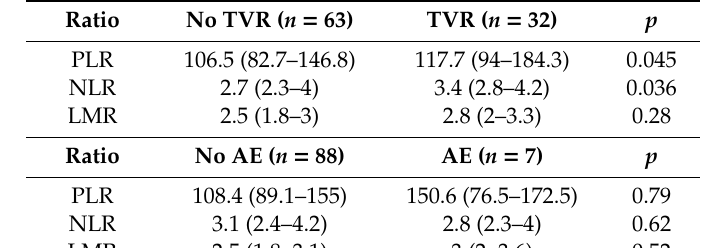
Table 2. Platelet-to-lymphocyte (PLR), neutrophil-to-lymphocyte (NLR) and lymphocyte-to-monocyte ratios. (LMR) in patients without and with target vessel restenosis (TVR), and in patients without and with an atherothrombotic event (AE) within 2-year follow-up.